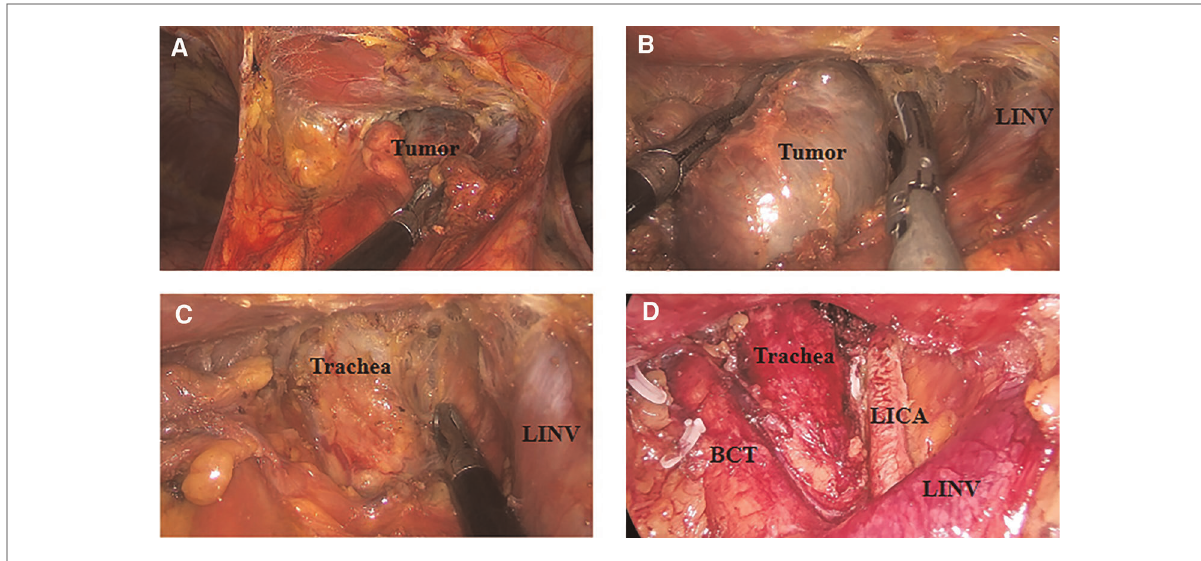
FIGURE 5 Resection of goiter through the subxiphoid approach. Mass was completely resected, and the blood vessels were clearly exposed. BCT, brachiocephalic trunk; LICA, left internal carotid artery; LINV, left innominate vein.